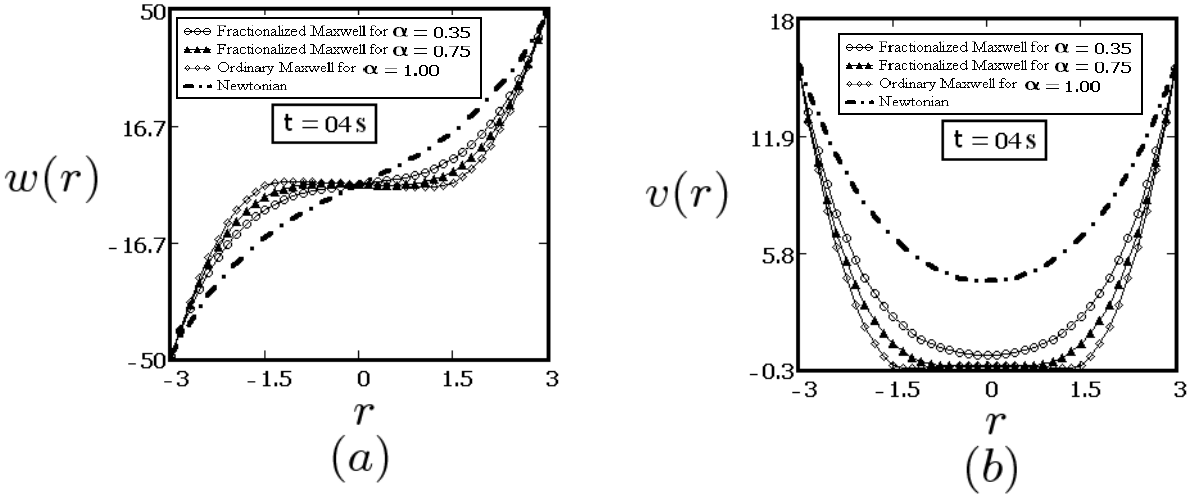
Fig. 8: Profiles of the velocity components w ( r , t ) and v ( r , t ) given by Eqs. (32), (33), (42), (43), (46) and (47) for fractionalized Maxwell, ordinary Maxwell and Newtonian fluids, for R = 3, Ω = 1, U = 1, ν = 0.9292, µ = 26, λ = 5, α = 0.35, &0.75, p = 2 and t = 4 s .